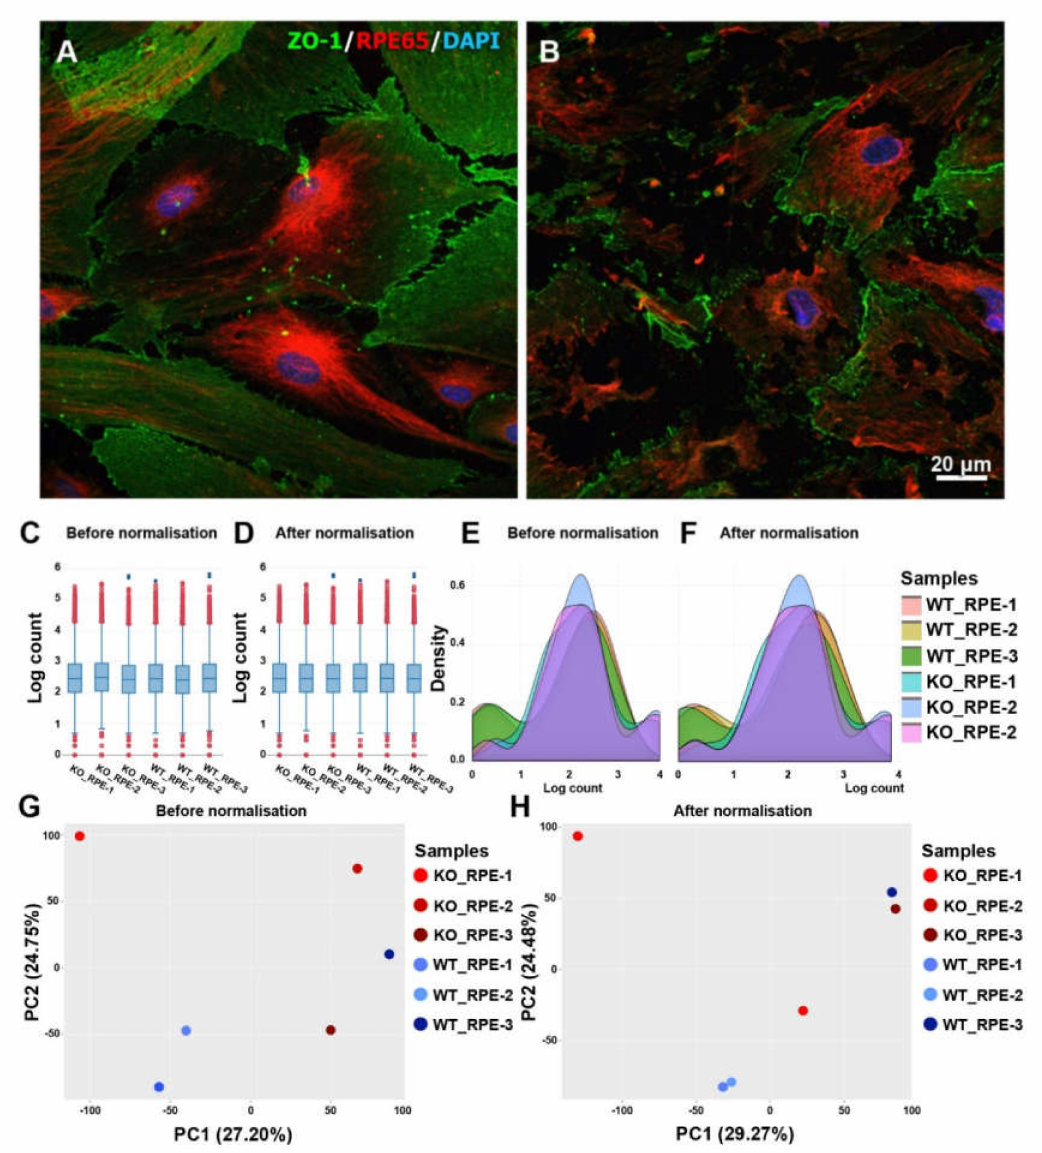
Figure 1. Representative double immunofluorescent staining images of ZO-1 and RPE65 in wild-type (WT) ( A ) and CXCR5 -deficient ( B ) retinal pigment epithelium (RPE) cells cultured on supporting cellulose substrate. Identification and correction of batch e ff ects: ( C ) Box plot before and ( D ) after normalization; ( E ) Density plot before and ( F ) after normalization; PCA plot before ( G ) and ( H ) after